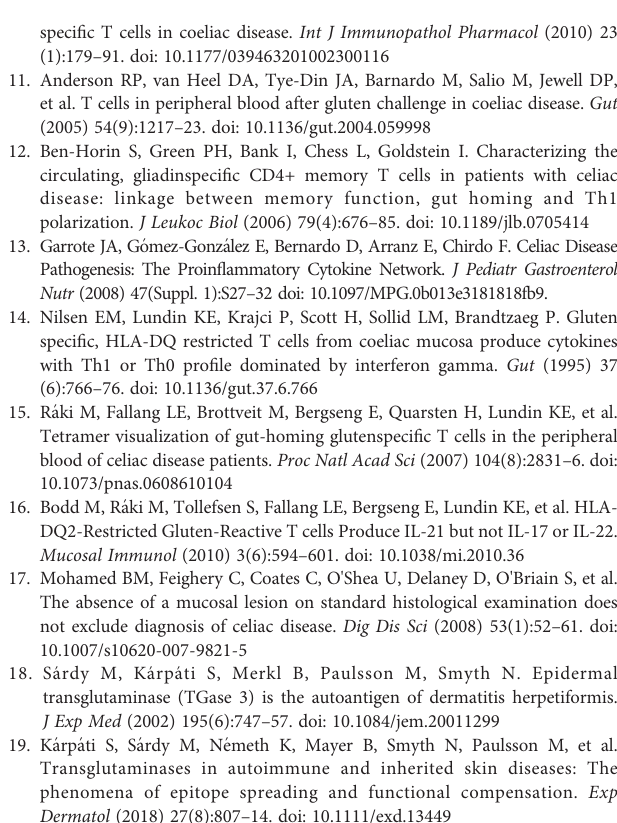
Supplementary Figure 1 | Direct immuno fl uorescence image of dermal biopsy of a DH patient. Granular IgA deposits (red arrows) at the dermal papillae and along dermal-epidermal junction detected on perilesional skin specimen from patient suffering with DH (Direct Immuno fl uorescence magni fi cation 200x). Supplementary Figure 2 | Membrane expression of T helper subsets ’ speci fi c surface molecules and chemokine receptors Membrane expression of CXCR3 (representative of Th1 cells), CCR6 and CD161 (representative of Th17 cells) and CRTH2 (representative of Th2 cells) in in vitro expanded CD4+ T cells from PB (black columns), skin (grey columns) and gut (white columns). Frequencies of CD4+ T cells were assessed in 7 DH patients, 7 CD patients and 4 healthy donors. Columns represent means ( ± SE). Supplementary Figure 3 | Single clone nature of cross-reacting T cell clones (TCCs), Representative dot plots of TCR V b Repertoire analysis on 2 TCCs cross- proliferating to TG2 and TG3: in the upper panel of the fi gure is shown the analysis on a TCC from a DH patient and in the lower panel one from a CD